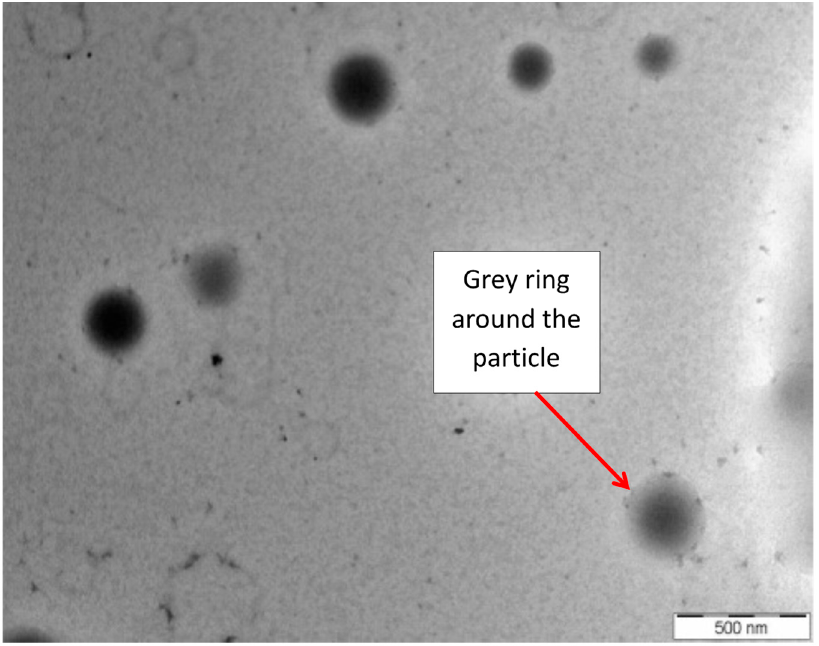
Figure 6. TEM images of NRL particle without stabilizers (0 phr).